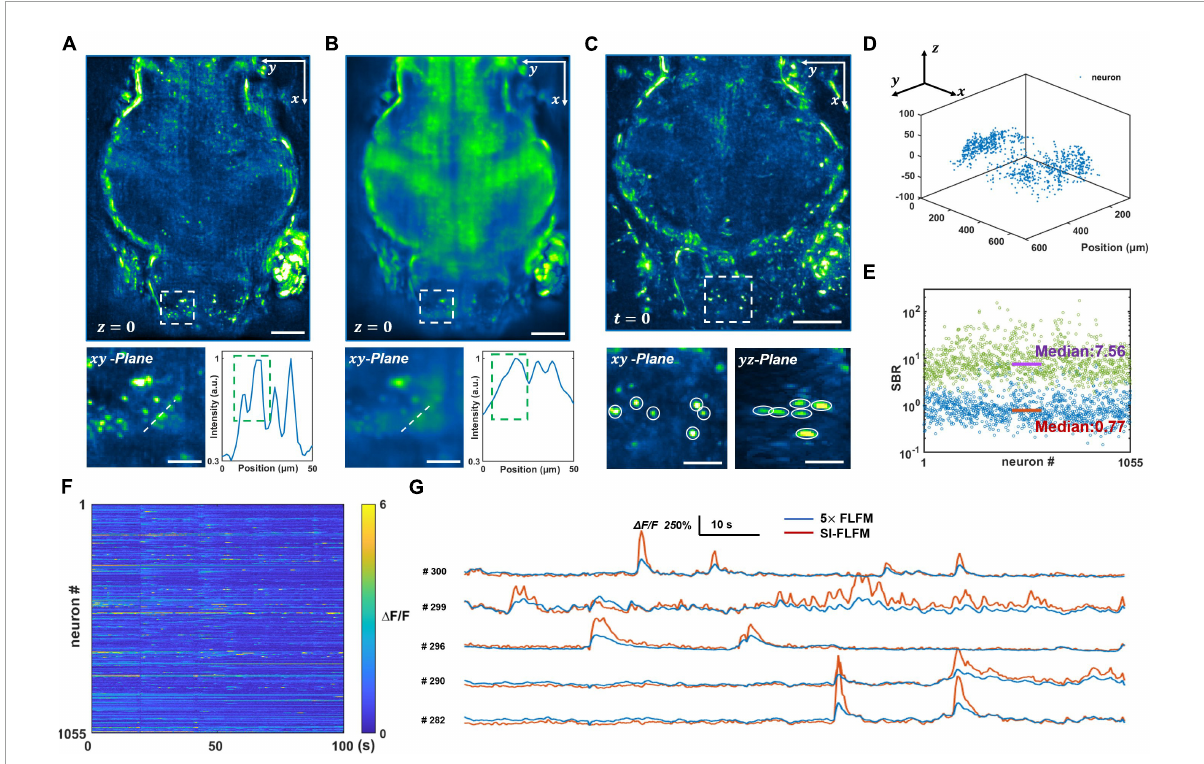
FIGURE3 Volumetric imaging of neural network activity in the brains of larval zebrafish in vivo . (A,B) Maximum intensity projects (MIPs) over recorded time in the plane at z = 0, processed in SI-FLFM and FLFM modes, respectively. Scale bar: 100 µ m in main figures and 30 µ m in insets. (C) 3D view images of neurons in larval zebrafish, MIP over z -axis at t = 0, processed in SI-FLFM mode. Scale bar: 100 µ m in main figures and 30 µ m in insets. (D) 3D positions of flashing neurons. (E) Statistics of SBR over all neurons in both SI-FLFM (Green dots) and FLFM (Blue dots) modes. The median values are 7.56 and 0.77 in SI-FLFM and FLFM modes, respectively. (F) Fluorescence signal maps of flashing neurons in SI-FLFM mode. (G) Comparison of fluorescence signals of selected neurons between SI-FLFM and FLFM mode. The latter is magnified by a factor of